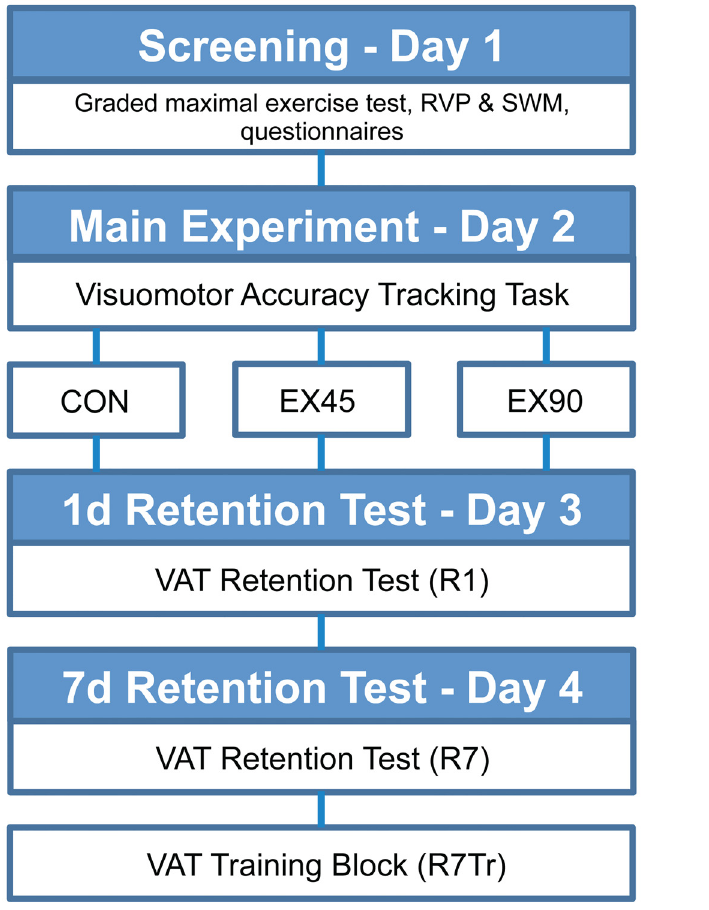
Fig 2. Study Design. Schematic illustration of the study